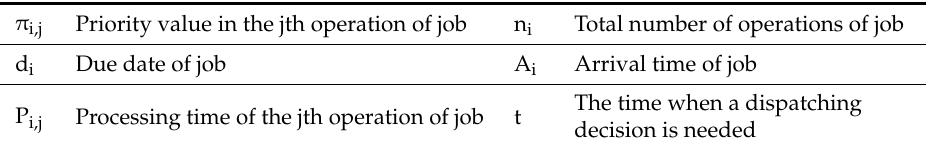
Table 1. Notations for Dispatching